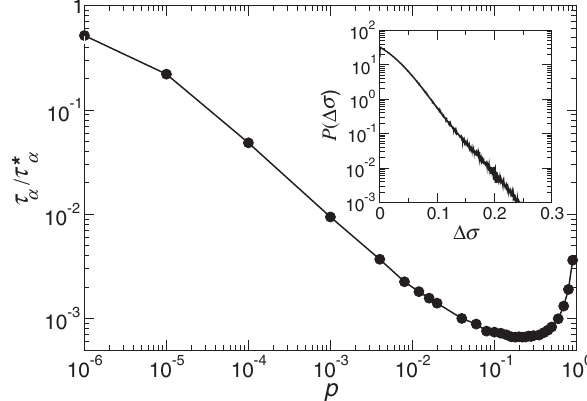
FIG. 2. The relaxation time τ α as a function of the swap attempt probability p , normalized by τ (cid:3) α , its value for standard Monte Carlo simulations when p ¼ 0 . A broad minimum indicates that p ≈ 0 . 20 optimizes the efficiency of the swap Monte Carlo algorithm. The inset shows the probability distri- bution of swap acceptance as a function of the diameter difference Δ σ ¼ j σ − σ j between the particles for which the swap move is 1 2 attempted. The system is a soft repulsive system of nonadditive particles studied in Sec. IV C, with ϵ ¼ 0 . 2 and T ¼ 0 . 101